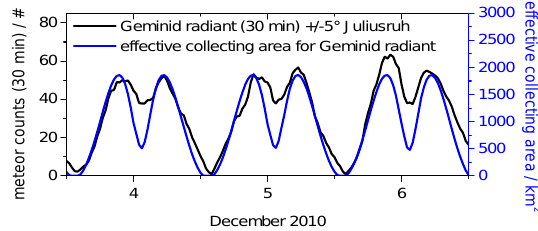
Fig. 9. Comparison of effective radar collecting area and observed meteor count rate for the Juliusruh MR. The x-tickmarks indicate 00:00UTC for each day.